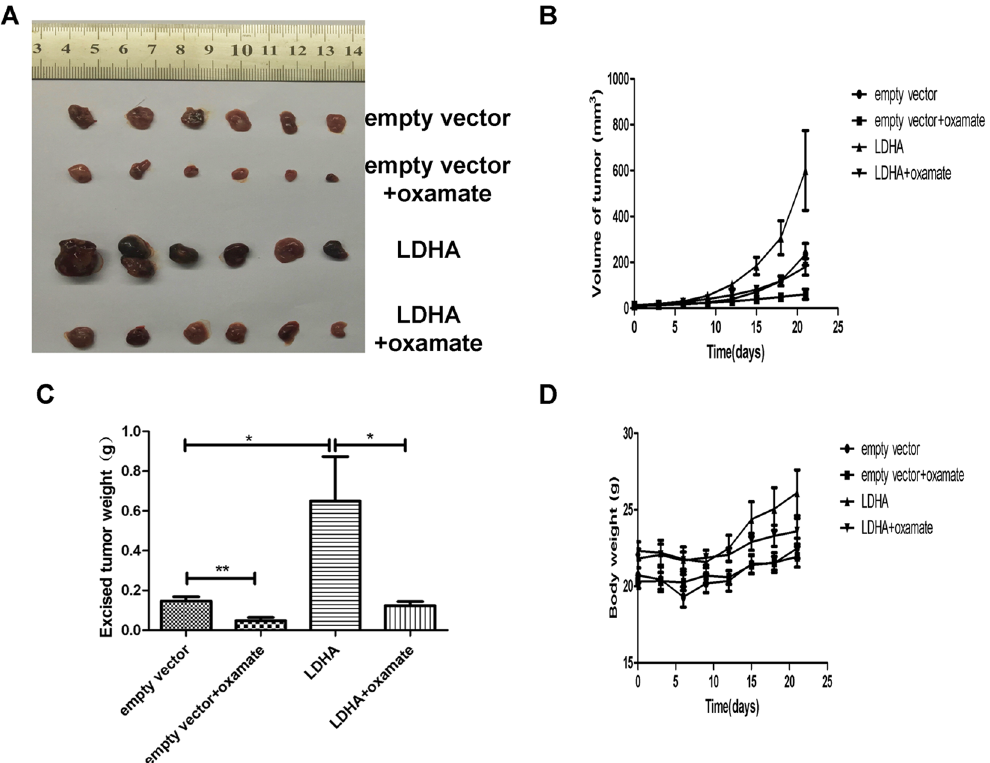
Figure 7. LDHA regulated growth of GH3 cells in vivo . ( A ) GH3 cells of transfected with empty vector or LDHA were injected subcutaneously in nude mice, excised tumors of different groups are shown. ( B ) Growth curve showed the tumor volume change of mice after administration of vehicle or oxamate. ( C ) The weight of the excised tumors in each group. ( D ) Body weight of mice in each group. * P < 0.05; ** P <